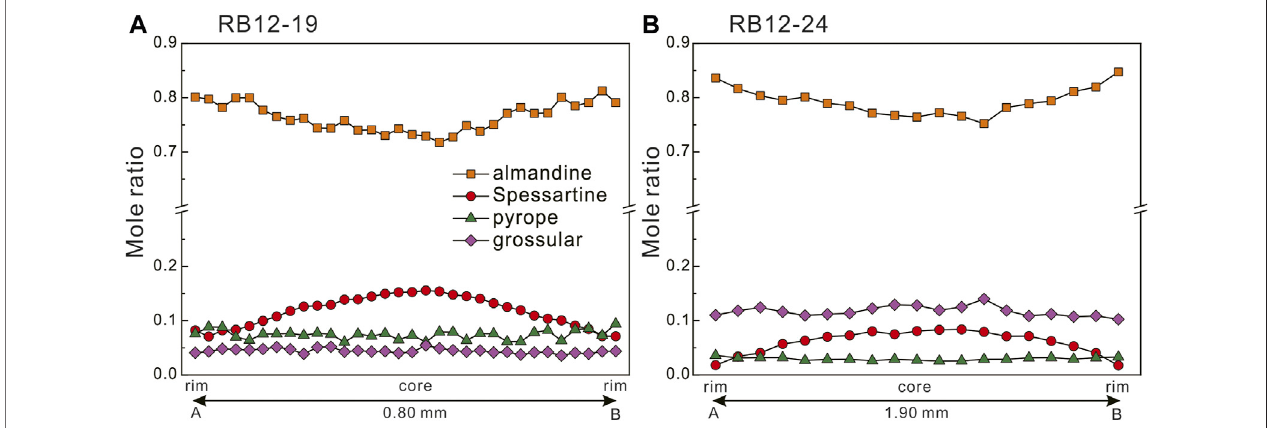
FIGURE 6 | Compositional pro fi les of garnet porphyroblasts from garnet – staurolite – two-mica schist samples RB12-19 (A) and RB12-24 (B) . (A,B) show garnet compositions matching those at the corresponding locations along the compositional pro fi le of garnet in Figure 4 .